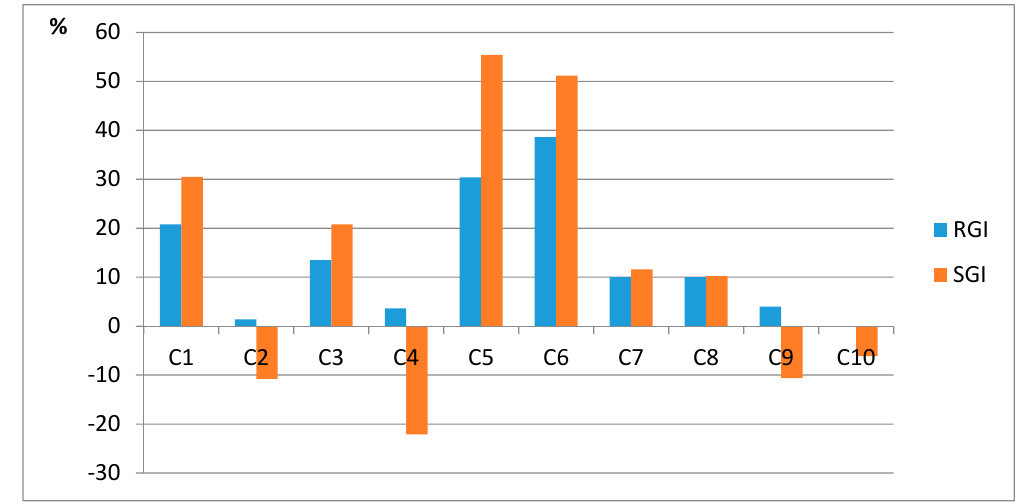
Figure 4. RGI and SGI values for analysed composts.